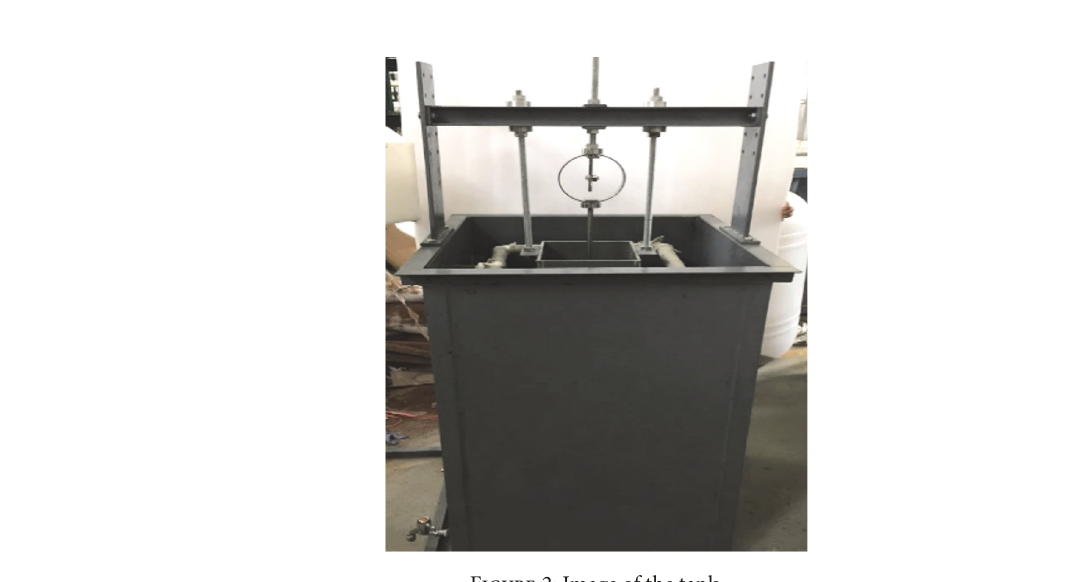
Figure 1: Experimental setup.